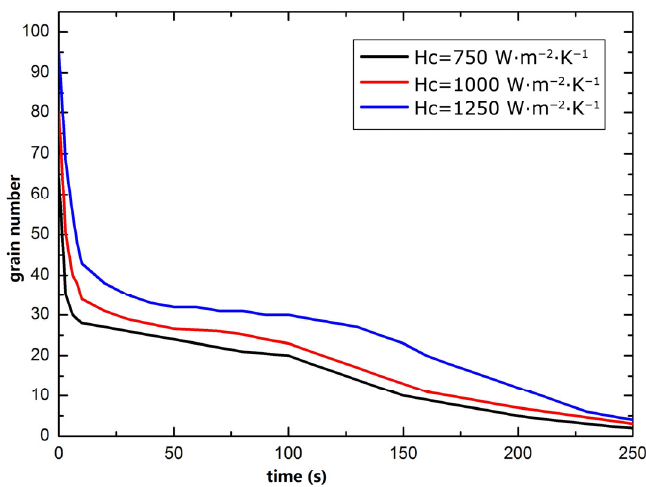
Figure 9. The grain number at different times with different heat transfer coefficients (Hc) at the bottom boundary. bottom